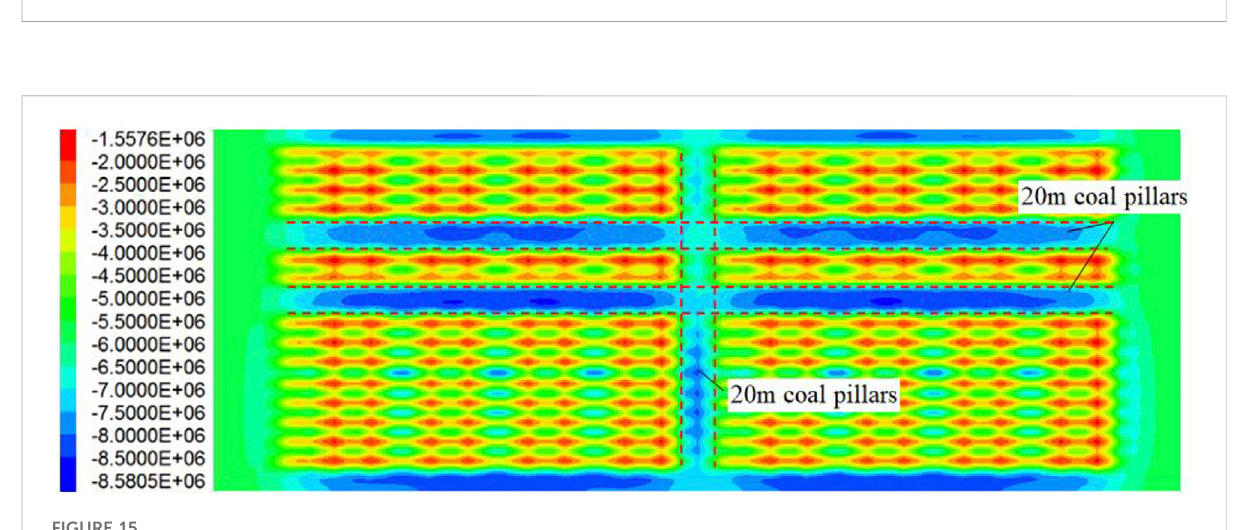
FIGURE 15 Vertical stress distribution of strata at 16m on top of 3# coal seam